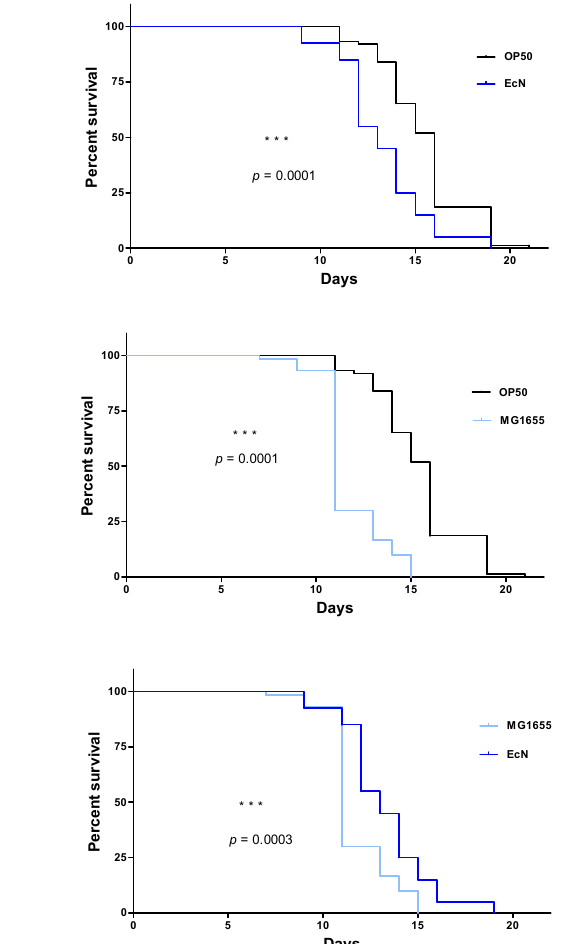
Figure 2. Pairwise comparisons of the effects of E. coli strains on C. elegans ’ lifespan. The “ n ” values in brackets correspond to the initial number of larvae investigated for each bacterial strain ( A ) OP50 ( n = 84) vs. EcN ( n = 45). ( B ) OP50 ( n = 84) vs. MG1655 ( n = 74). ( C ) MG1655 ( n = 74) vs. EcN ( n = 45). The statistical significance of intergroup differences was assessed with a log-rank (Mantel-Cox) test; ***: p < 0.001.